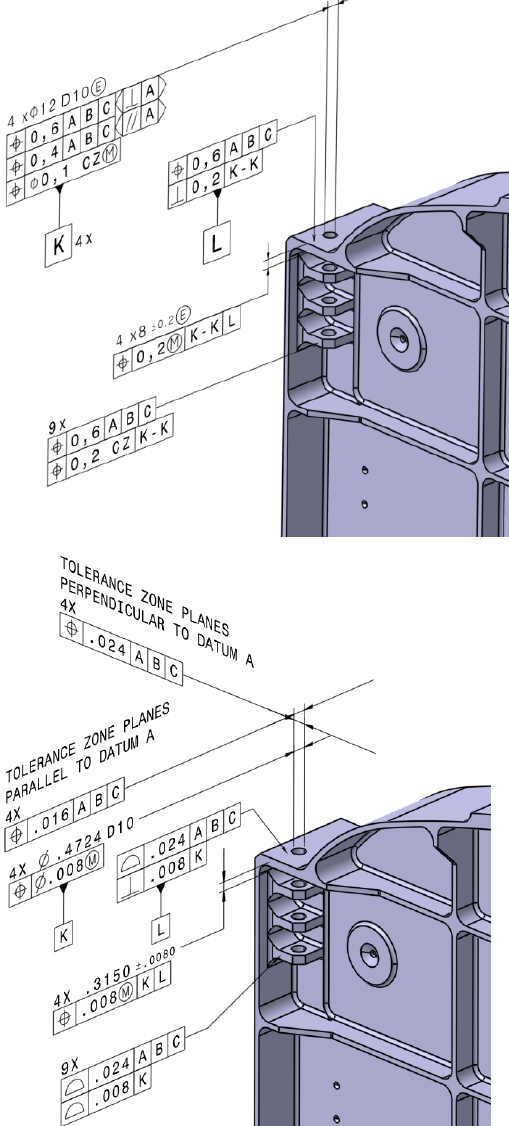
Figure A5. Hinge line in ISO model ( top illustration) and Hinge line in ASME model ( bottom illus- tration).